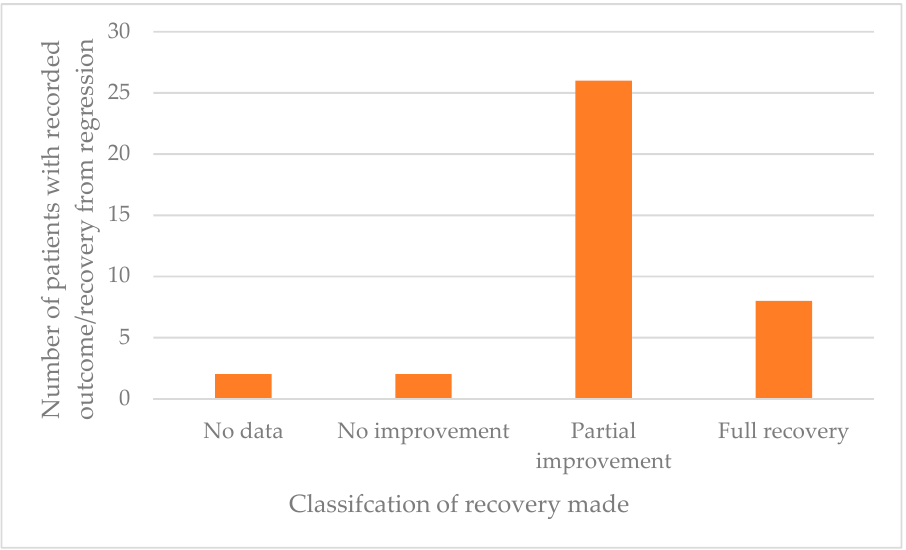
Figure 7. Recovery rate of 39 case study patients (Group A).